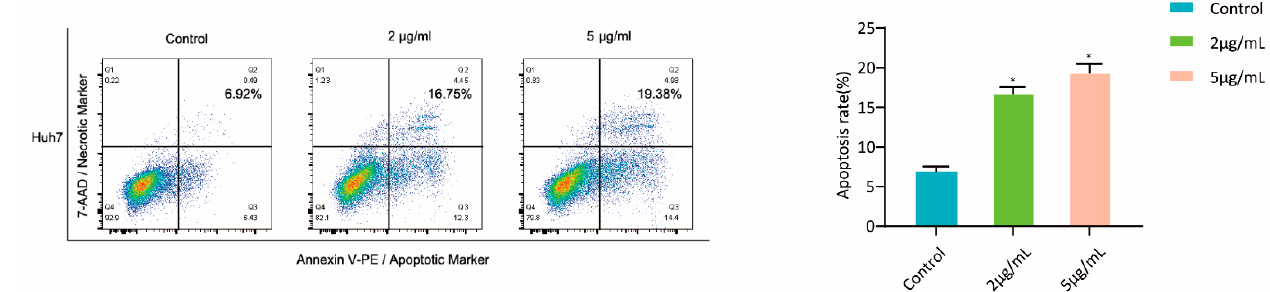
Figure 4. Annexin V PE/7-ADD stained apoptotic cells induced by compound 4 in HuH-7 cells. All data shown represent the means ± S.D. of 3 independent experiments. ∗ p < 0.05.